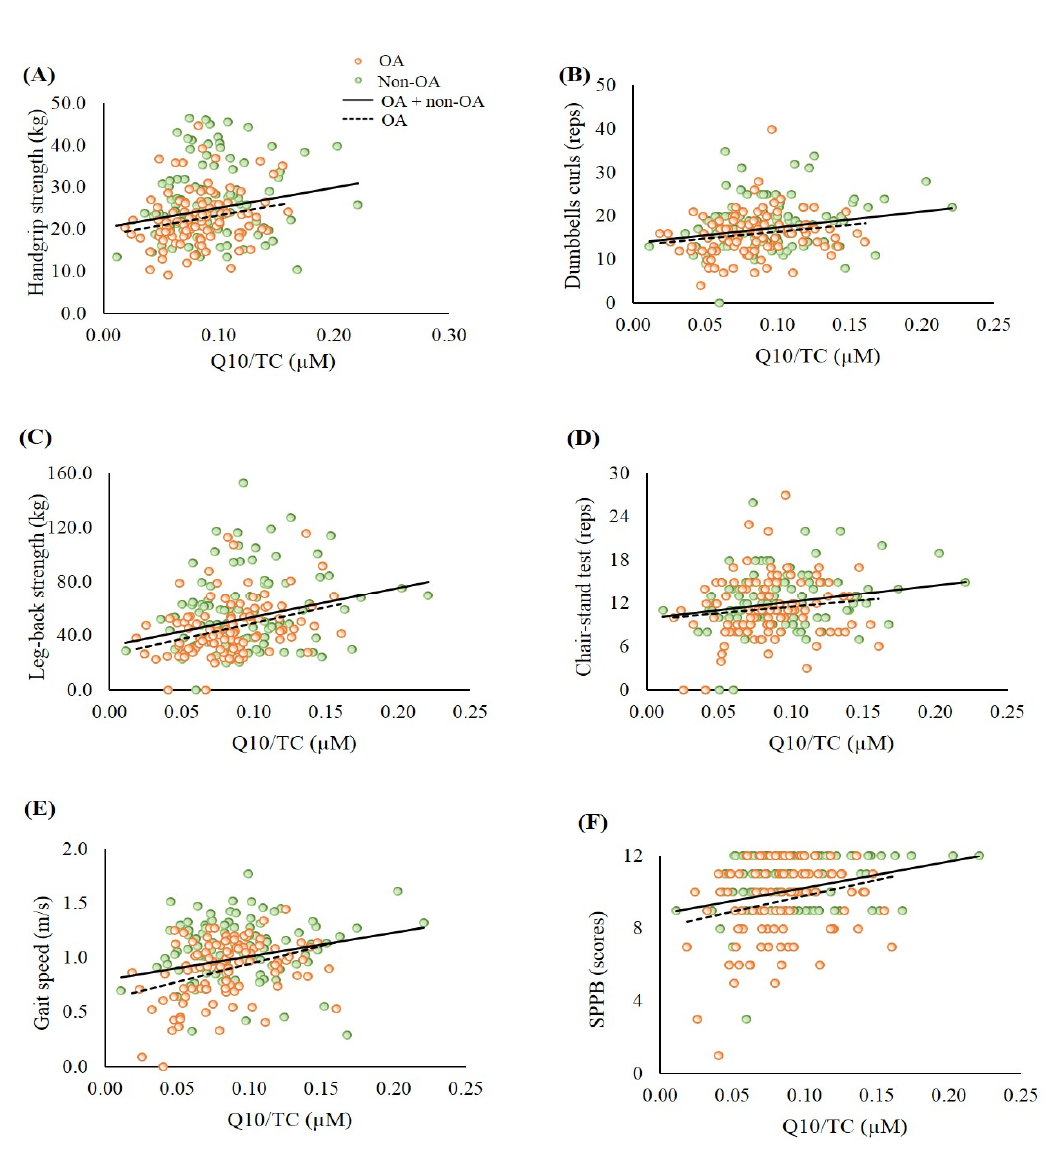
Figure 3. Correlations between coenzyme Q10 status and muscle strength and muscle endurance. ( A ) Correlation between coenzyme Q10 status and handgrip strength. OA group: r = 0.24, p = 0.01; OA + non-OA group: r = 0.20, p < 0.01; ( B ) Correlation between coenzyme Q10 status and dumbbells curls. OA group: r = 0.24, p = 0.02; OA + non-OA group: r = 0.22, p < 0.01; ( C ) Correlation between coenzyme Q10 status and leg-back strength. OA group: r = 0.34, p < 0.01; OA + non-OA group: r = 0.28, p < 0.01; ( D ) Correlation between coenzyme Q10 status and chair- stand test. OA group: r = 0.13, p = 0.20; OA + non-OA group: r = 0.15, p = 0.03; ( E ) Correlation between coenzyme Q10 status and gait speed. OA group: r = 0.35, p < 0.01; OA + non-OA group: r = 0.24, p < 0.01; ( F ) Correlation between coenzyme Q10 status and SPPB. OA group: r = 0.21, p = 0.04; OA + non-OA group: r = 0.20, p < 0.01. OA, osteoarthritis; SPPB, short physical performance battery; TC, total cholesterol.